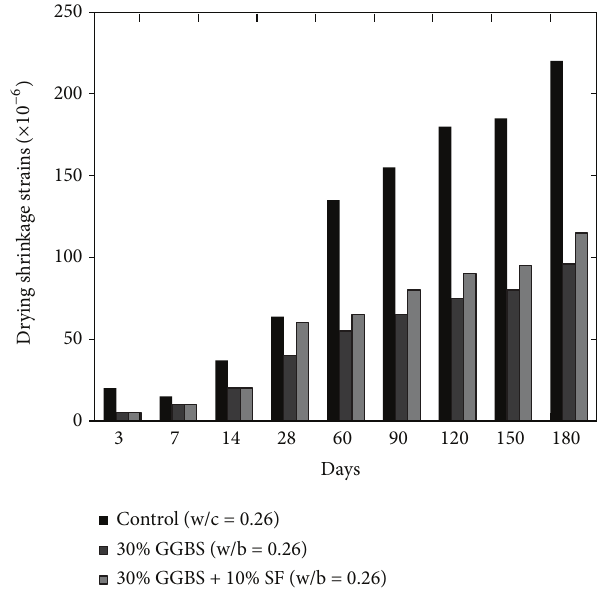
Figure 2: Effect of FA content and type on the drying shrinkage of FA concrete [25, 26].